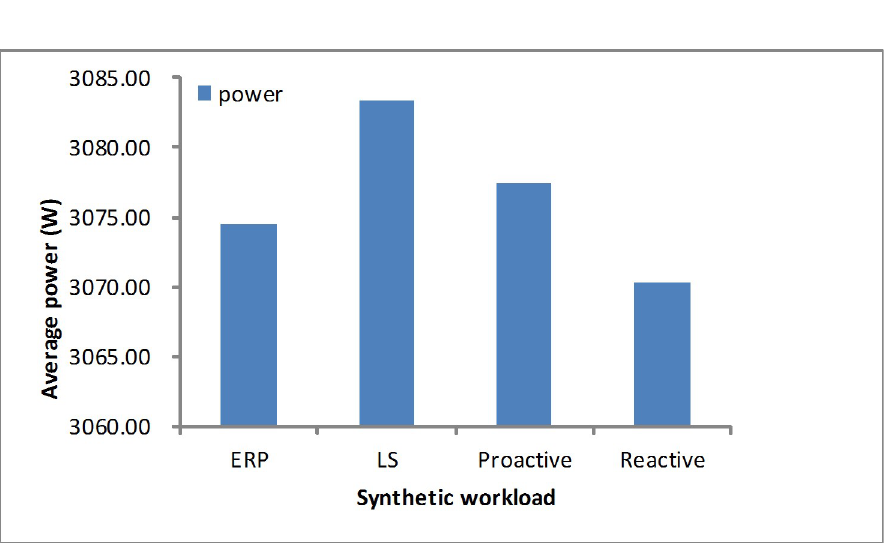
Fig 18. Energy consumption in the synthetic